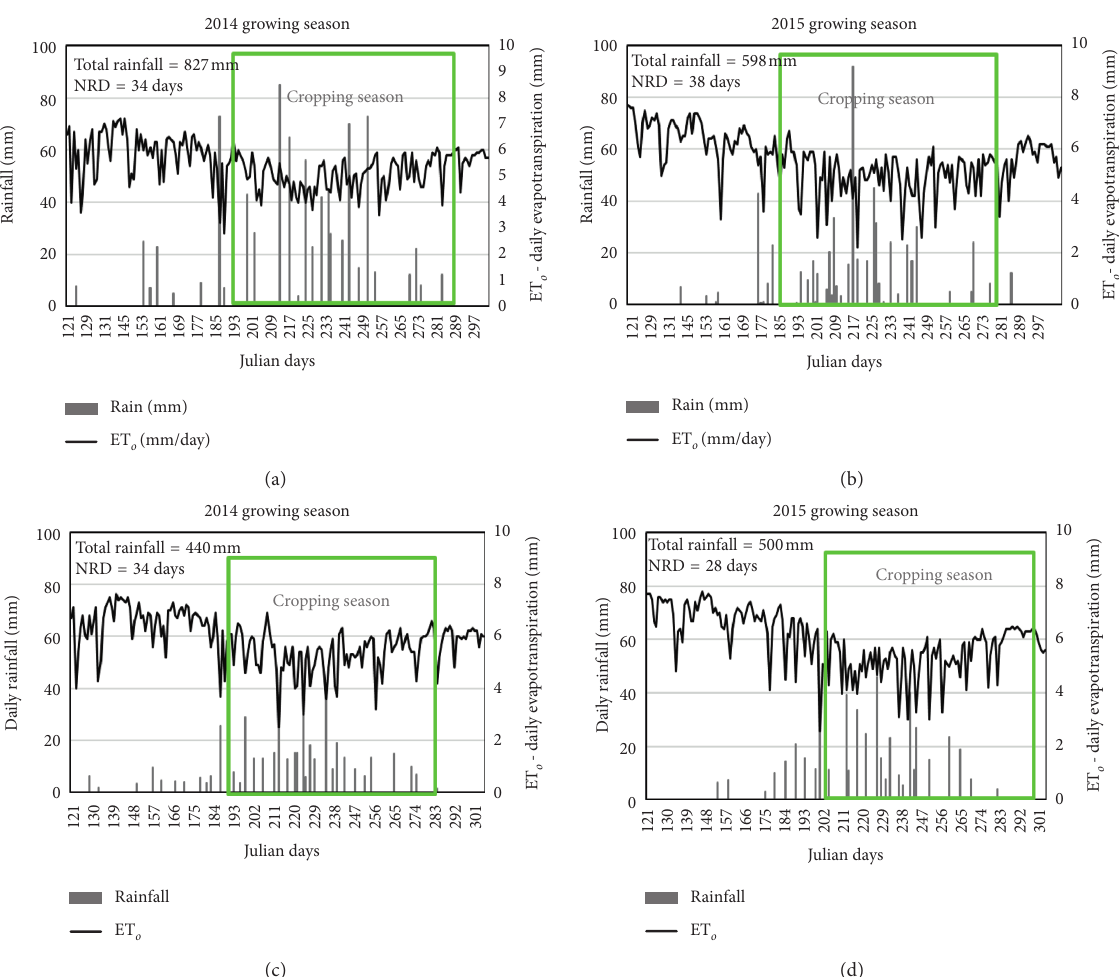
Figure 1: Daily rainfall distribution and evapotranspiration (ET